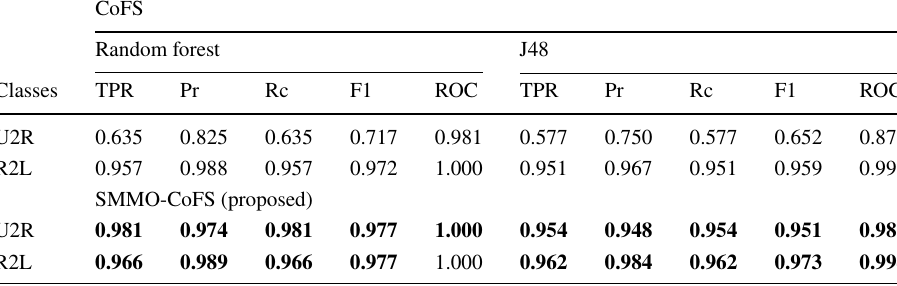
Bold values indicate the best results obtained for